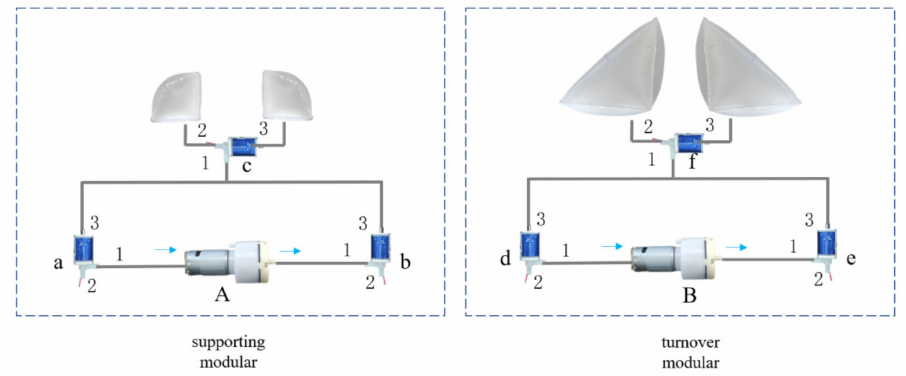
Figure 7. Schematic diagram of gas